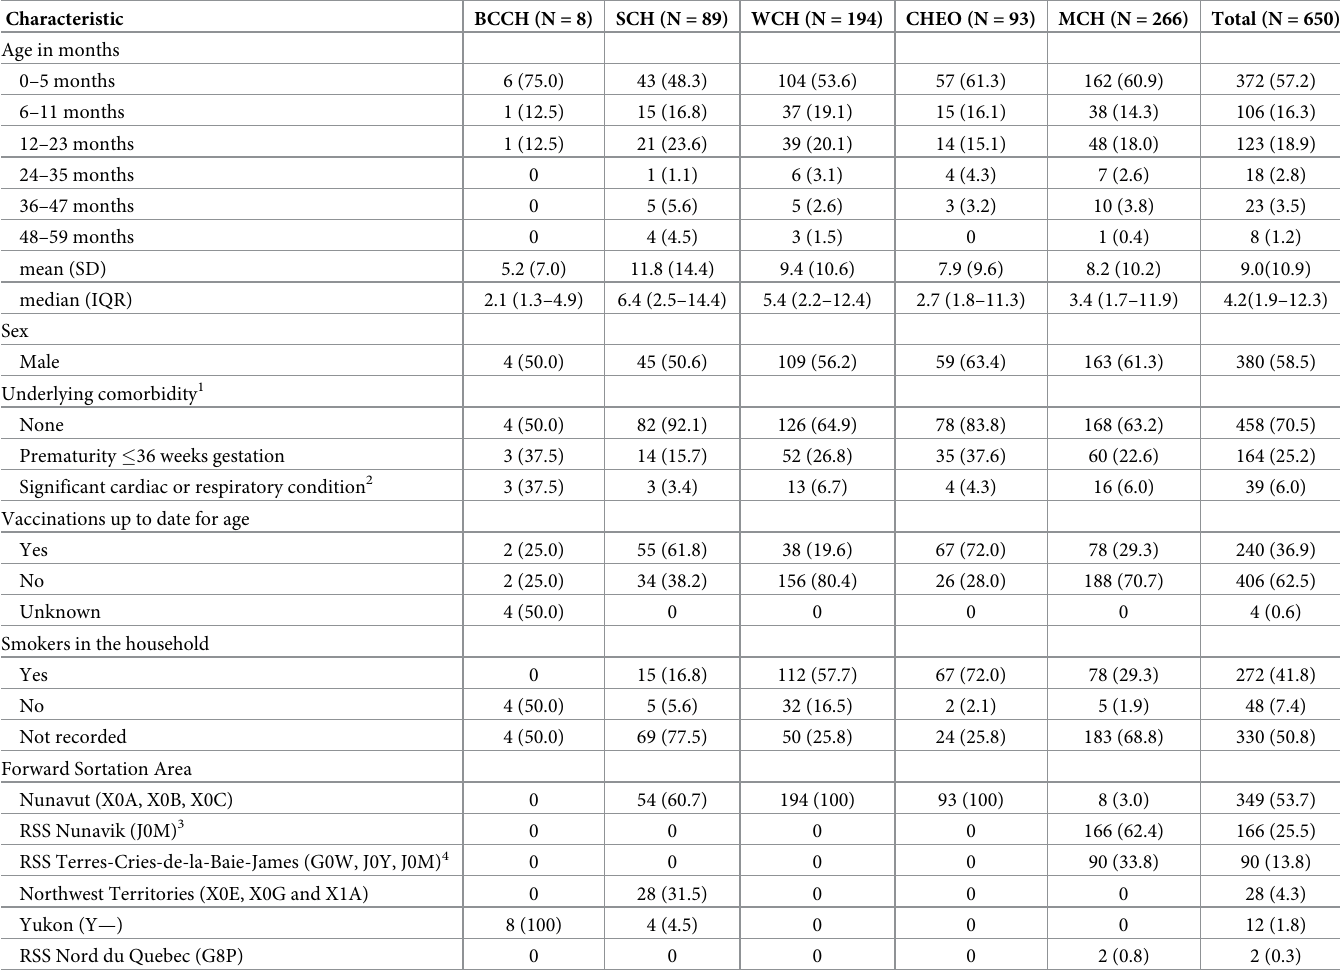
Table 1. Demographic characteristics of 650 children transported urgently by air from northern Canada to five tertiary care centers (n, %).